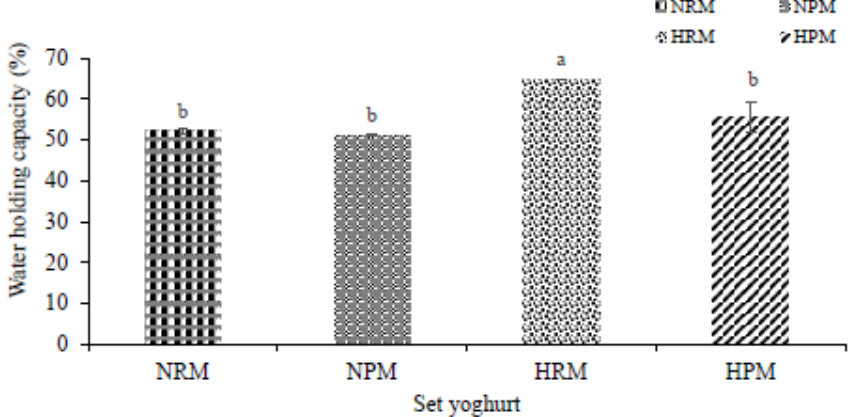
Figure 4. Homogenization-induced substantial changes to water-holding capacity of set yogurt produced from raw milk or processed milk combined with an enriched MFGM. a, b represent the significant differences in the total acidity among set yoghurts.